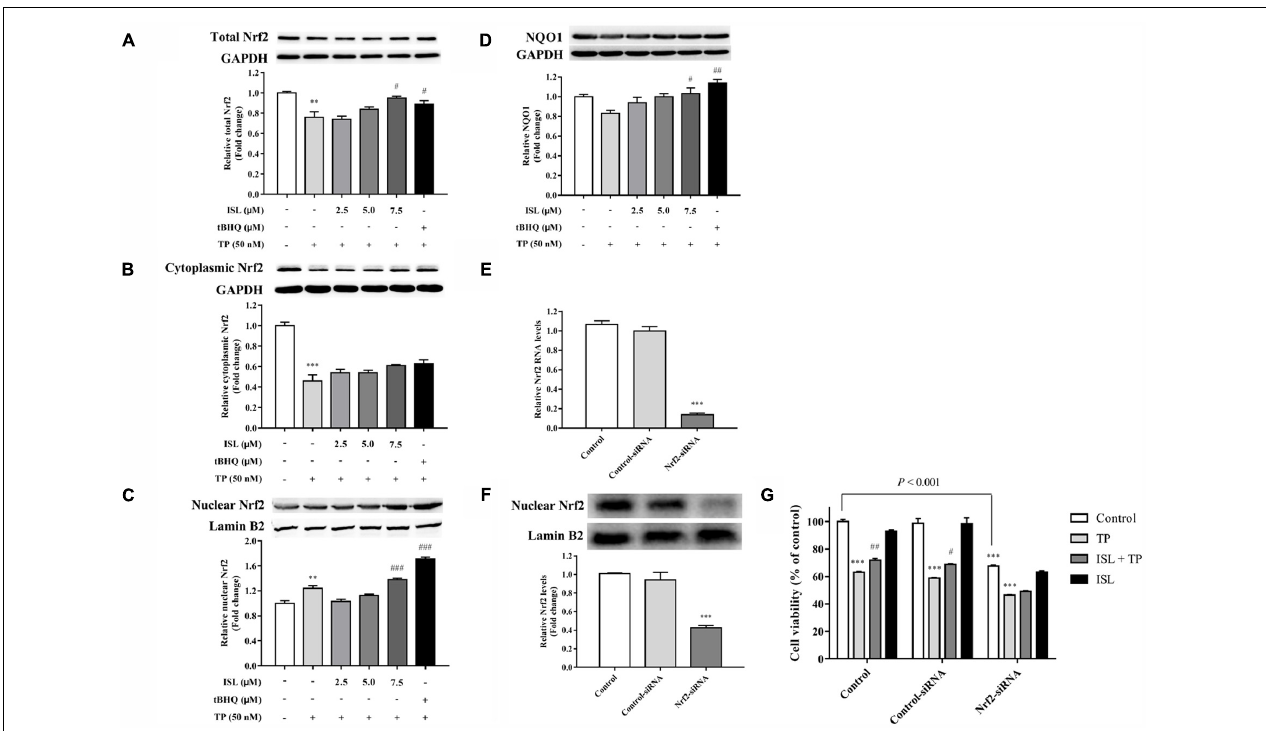
FIGURE 2 | Role of nuclear transcription factor E2-related factor 2 (Nrf2) in TP-induced cell death and ISL-induced protective effects. Effects of TP, ISL, or ISL + TP on the protein levels of (A) total, (B) cytoplasmic, and (C) nuclear Nrf2 and (D) NAD(P)H: quinine oxidoreductase 1 (NQO1) in L02 cells. Cells were treated with 50 nM TP with or without 2.5, 5, and 7.5 µ M ISL pretreatment. The tBHQ (15 µ M) was used as an Nrf2 inducer. Cell lysates were analyzed by Western blot. Role of Nrf2 in the protection against TP-induced cytotoxicity in L02 cells. Cells were transiently transfected with Nrf2-siRNA or Control-siRNA before TP, ISL, or ISL + TP treatment. (E) RT-PCR analysis of Nrf2 mRNA levels 48 h after the transfection. (F) Western blot analysis of nuclear Nrf2 protein levels 72 h after the transfection. (G) Cell viability determined by MTT assay. Data were presented as means ± SE ( n = 3); ∗∗ P < 0.01 vs. the control group, ∗∗∗ P < 0.001 vs. the control group, # P < 0.05 vs. the TP group, ## P < 0.01 vs. the TP group, and ### P < 0.001 vs. the TP